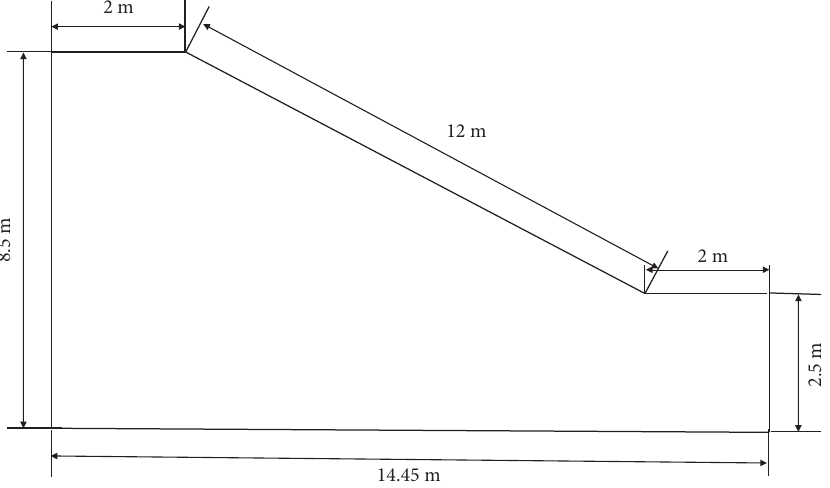
Figure 5: Geometric graph of slope. Table 2: Parameters of cohesive soil of slope.